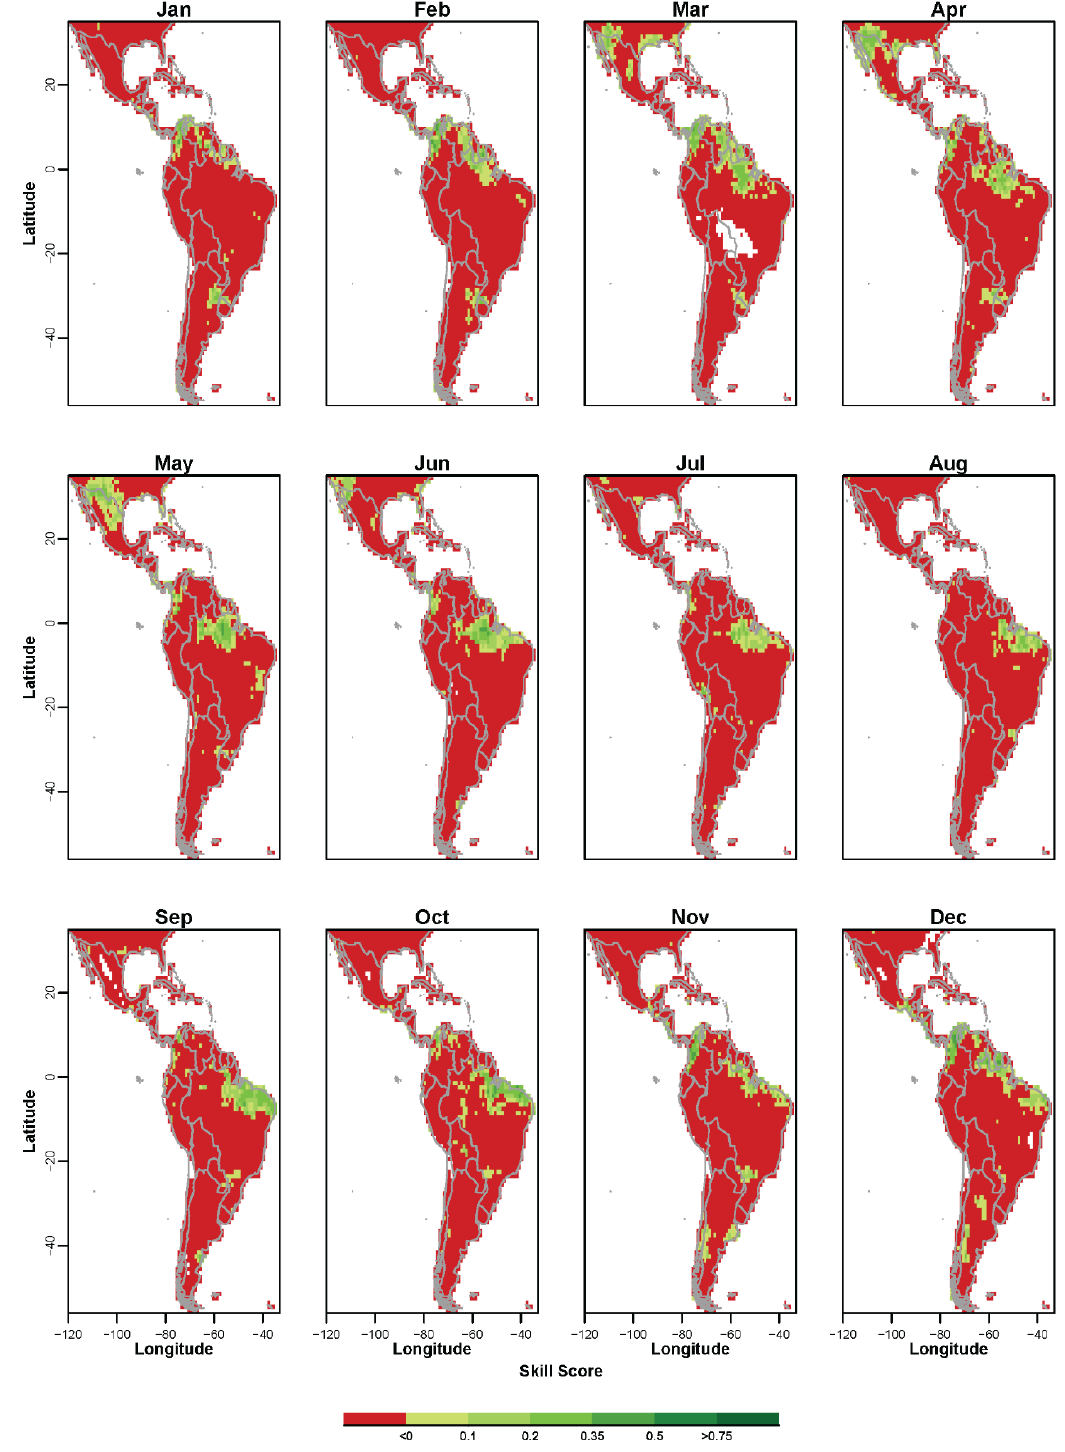
Figure A4. Skill Score of the SPI6 at 6-month lead time forecast measured in terms of the RMSE relative to climatological RMSE for the hindcast period (1981–2010).